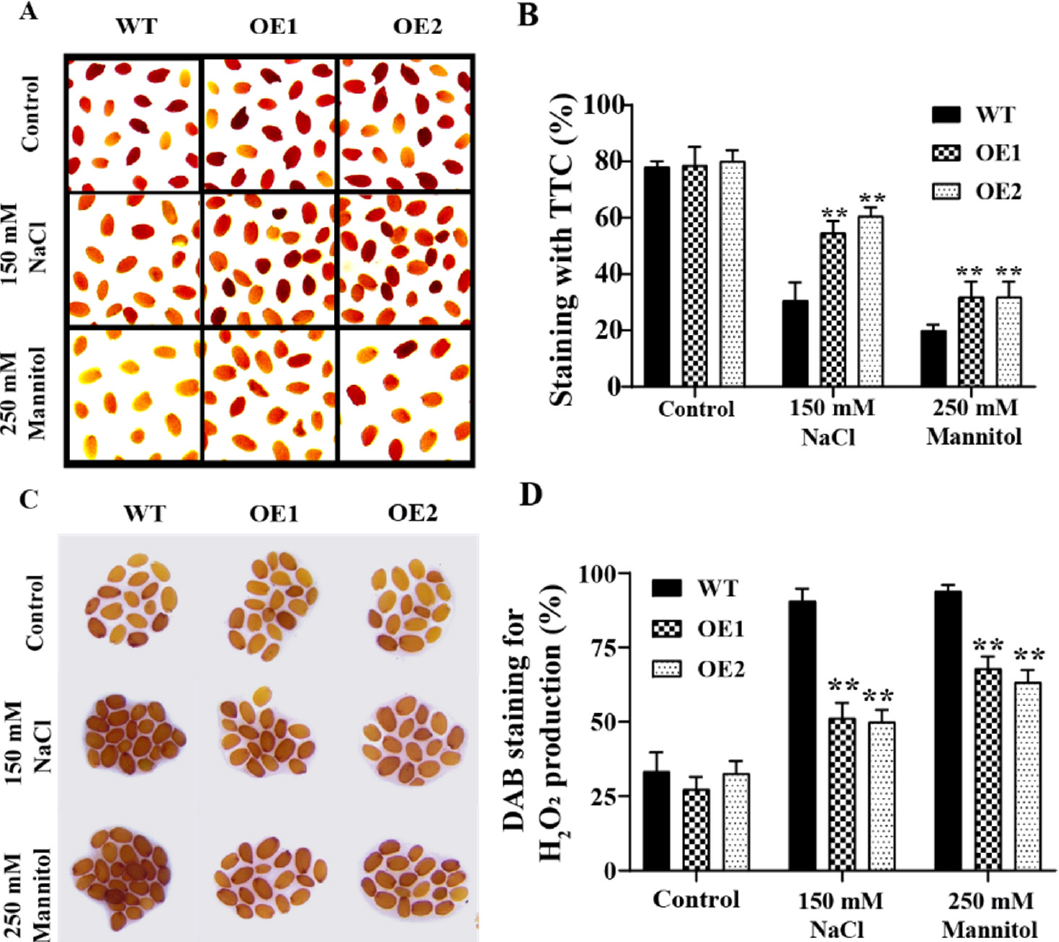
Figure 5. TTC staining and DAB staining of the mature seeds harvested from the GmPAL1.1 over- expressing Arabidopsis (OE) lines and WT grown under normal condition. ( A , B ) Seed viability of the WT and OE lines germinated under 150 mM NaCl and 250 mM mannitol conditions for 12 h, respectively. Dark-red staining indicated viable seeds, while light-pink staining indicated reduced seed viability. ( C , D ) DAB staining of the WT and OE lines of seeds germinated under 150 mM NaCl and 250 mM mannitol conditions for 12 h, respectively. Values are mean ± SD of three biological replicates. ** indicated significant differences at 1% probability levels between the WT and transgenic Arabidopsis lines.